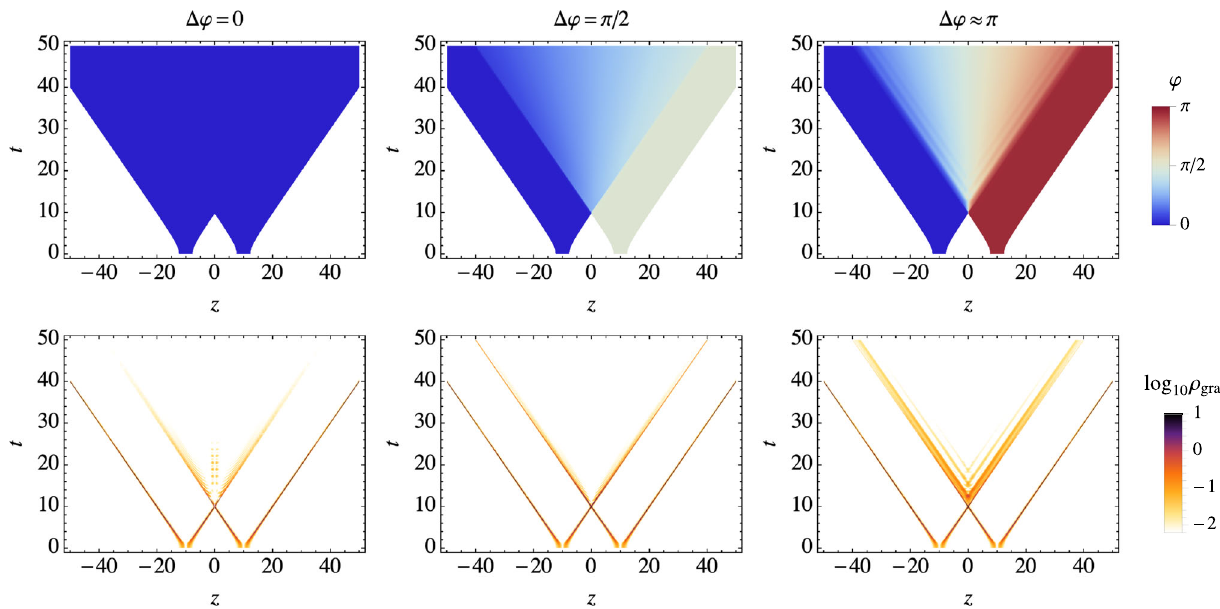
Fig. 1 Collision of two complex scalar field bubbles in the simulation units. Each column corresponds to one simulation. The color coding in the upper panels shows the complex phase of the scalar field, whereas